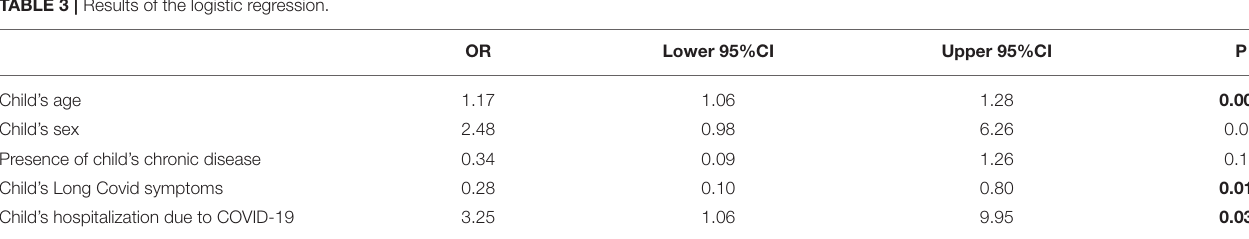
TABLE 3 | Results of the logistic